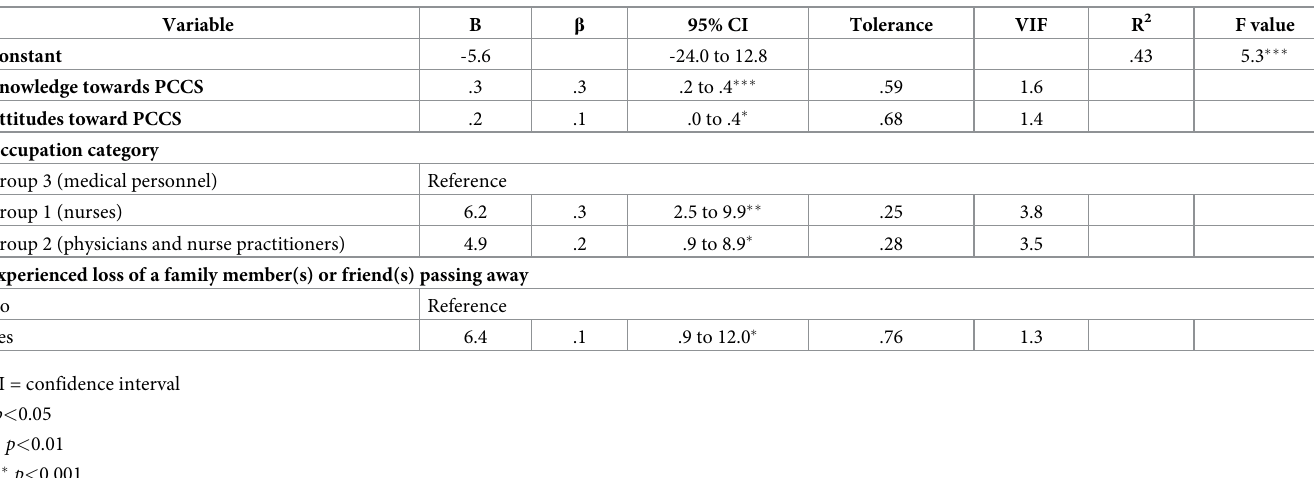
Table 4. Multiple Linear Regression for Practices toward